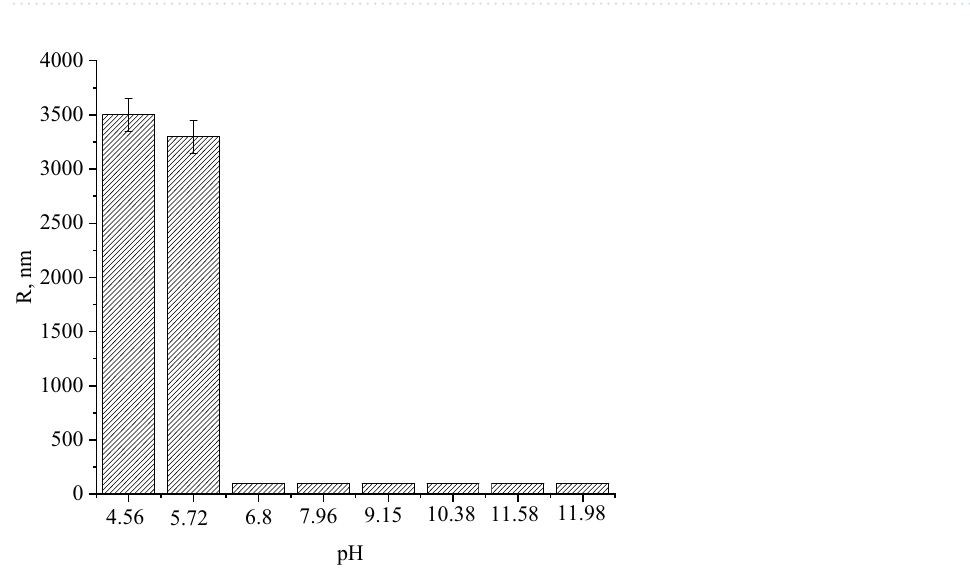
Figure 12. Dependence of the average hydrodynamic radius of particles (R) on the pH.